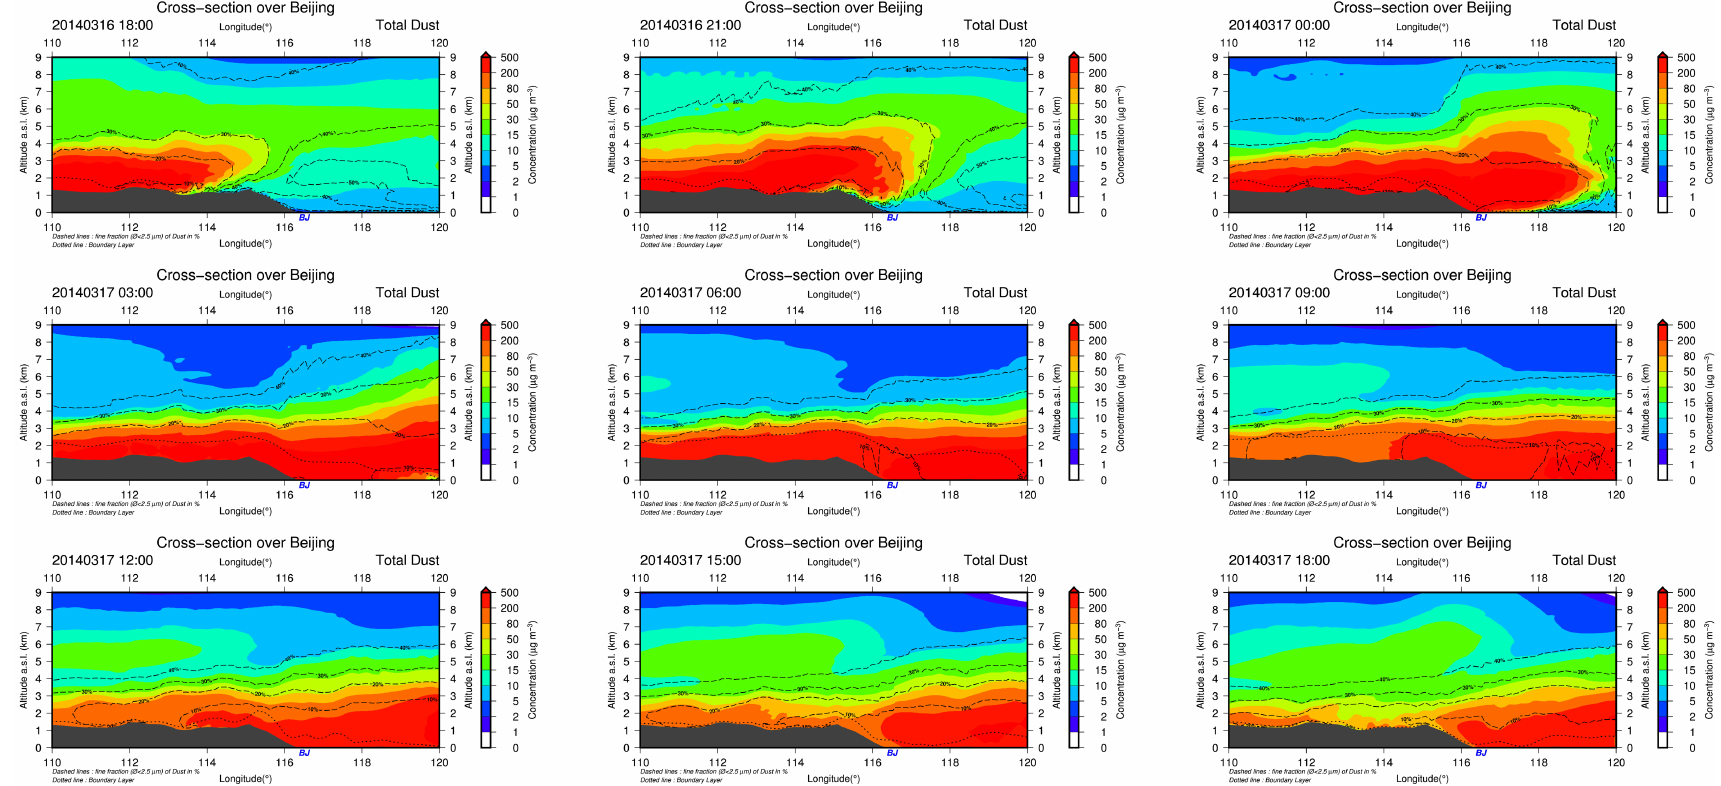
Figure 28. Arrival of the second dust episode over Beijing. Longitudinal cross section of total dust concentrations fields (Altitude versus longitude) at 39.9 ◦ N latitude from 110 ◦ E to 120 ◦ E passing over Beijing (BJ in blue letters) from 16 March 18:00 UTC to 17 March 18:00 UTC. The dotted line represents the height of the boundary layer, the dashed lines represent the fraction of fine dust in percent. The full sequence of dust transport for the three episodes is depicted in Figures S16 and S17 in Supplementary